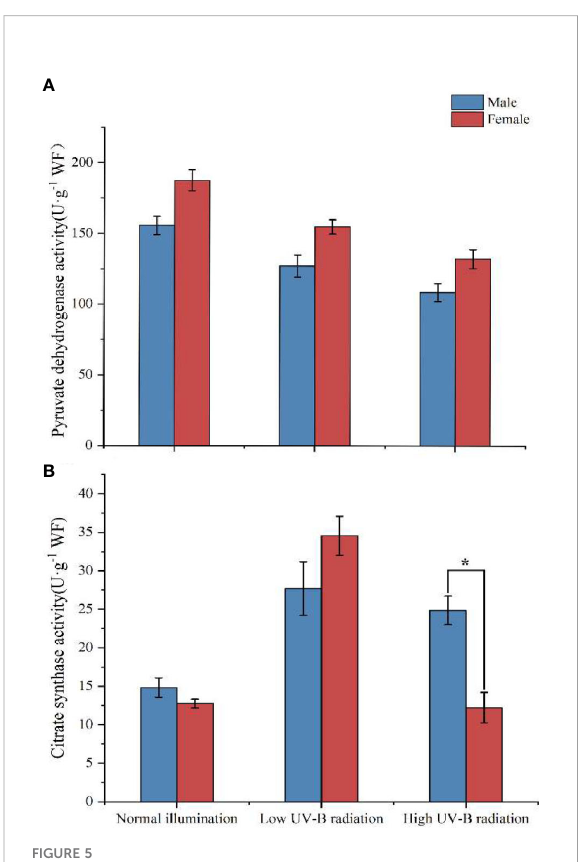
FIGURE 5 The activities of pyruvate dehydrogenase (A) and citrate synthase (B) in male and female S. thunbergii algaes under different conditions.